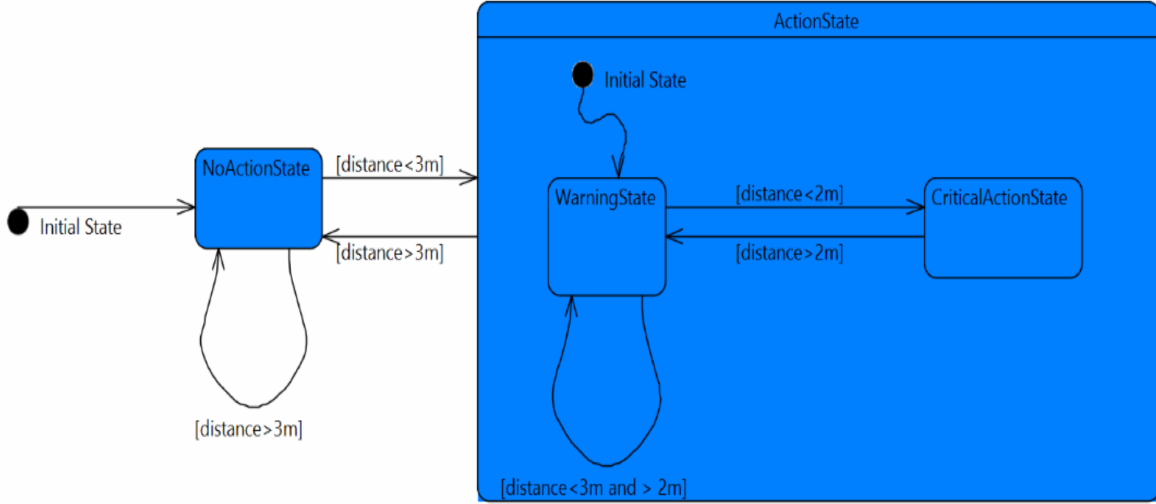
Figure 12. SysML high-level-state machine diagram for obstacle